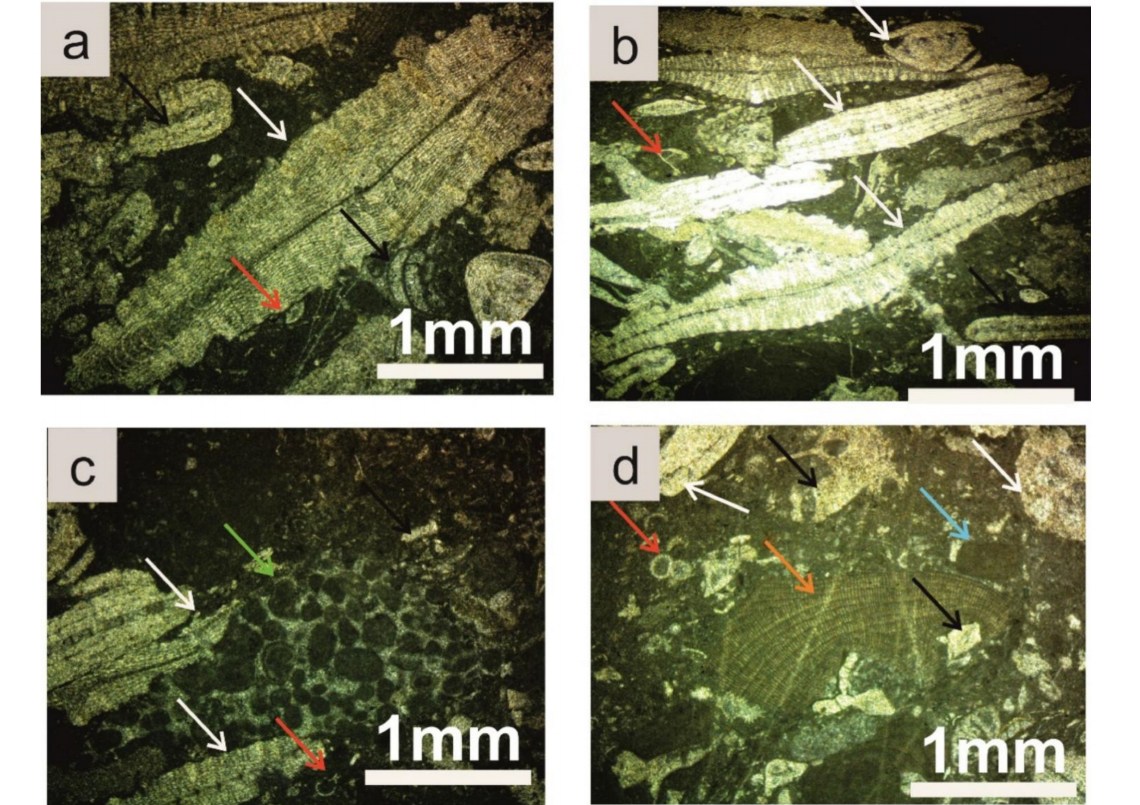
Figure 17. Microfacies type F1: Allochthonous, bioclastic-lithoclastic packstone/floatstone microbrec- cia of Eocene age. ( a ) bioclasts (black arrow), benthic foraminifera (white arrow), planktic foraminifera (red arrow), sample M6, ( b ) bioclasts (black arrow), benthic foraminifera (white arrow), planktic foraminifera (red arrow), sample M12, ( c ) bioclasts (black arrow), planktic foraminifera (red arrow), benthic foraminifera (white arrow), oolitic grainstone and coated grains (green arrow), sample M6, ( d ) bioclasts (black arrow), benthic foraminifera (white arrow), micritic clasts (blue arrow), algae (orange arrow), sample M5.